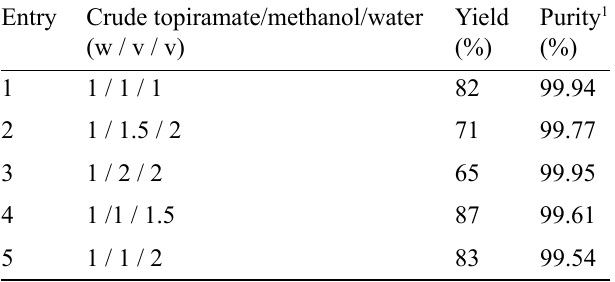
Table 1. Amount of methanol and water used for purification of topiramate.